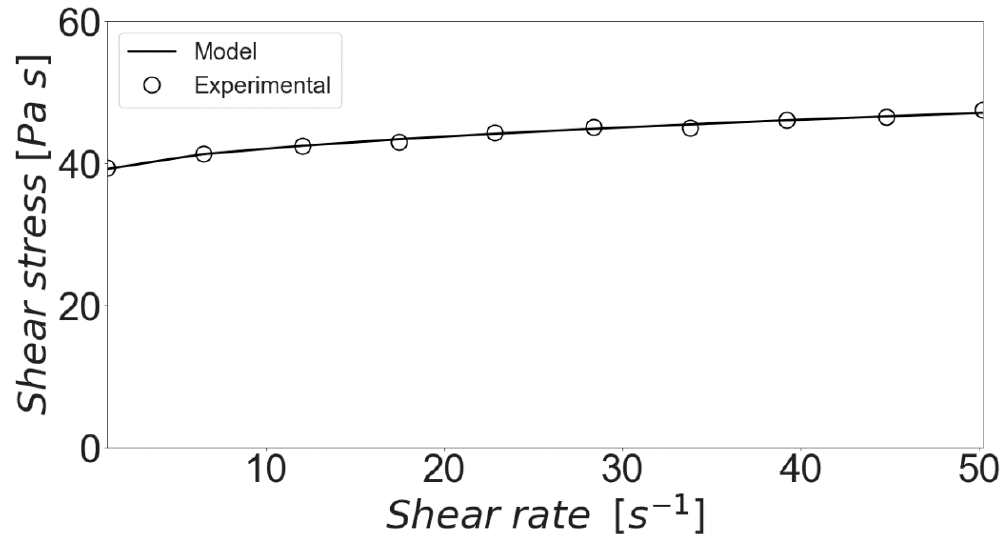
Figure 4. Experimental vs model shear stress profile.